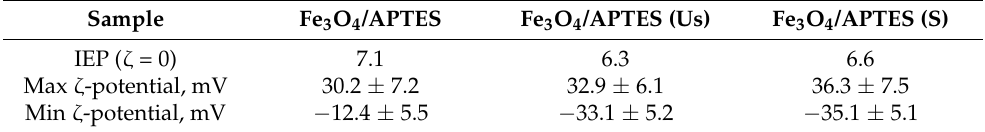
Table 2. Electro-kinetic parameters of MNPs.